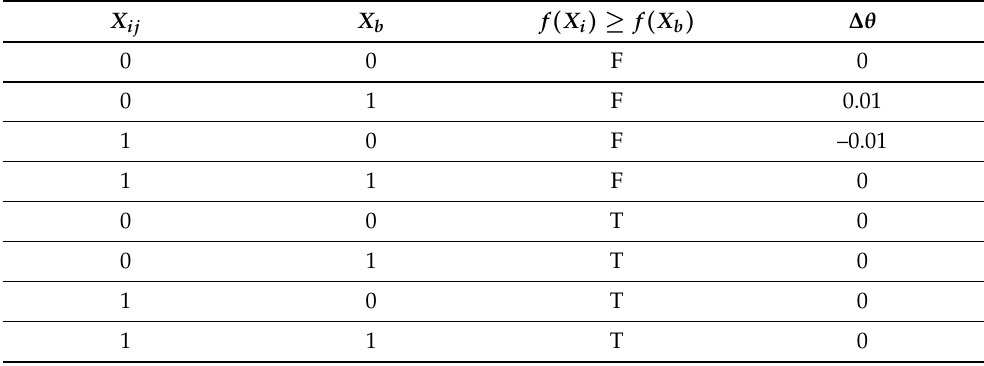
Table 1. Predefined value of ∆ θ .